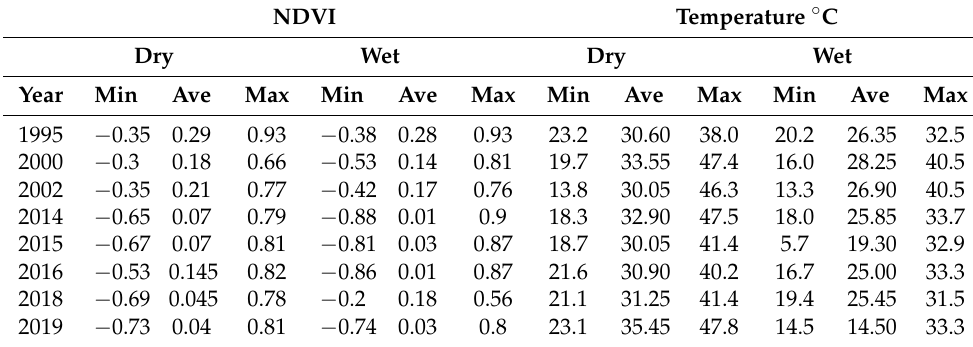
Figure 3. Spatiotemporal variation of land surface temperature and NDVI in dry season ( A ), wet season ( B ) and urban zone extension ( C ). Table 5. Changes in Normalized Difference Vegetation Index (NDVI) and land surface temperature (LST) of the metropolitan city of M é